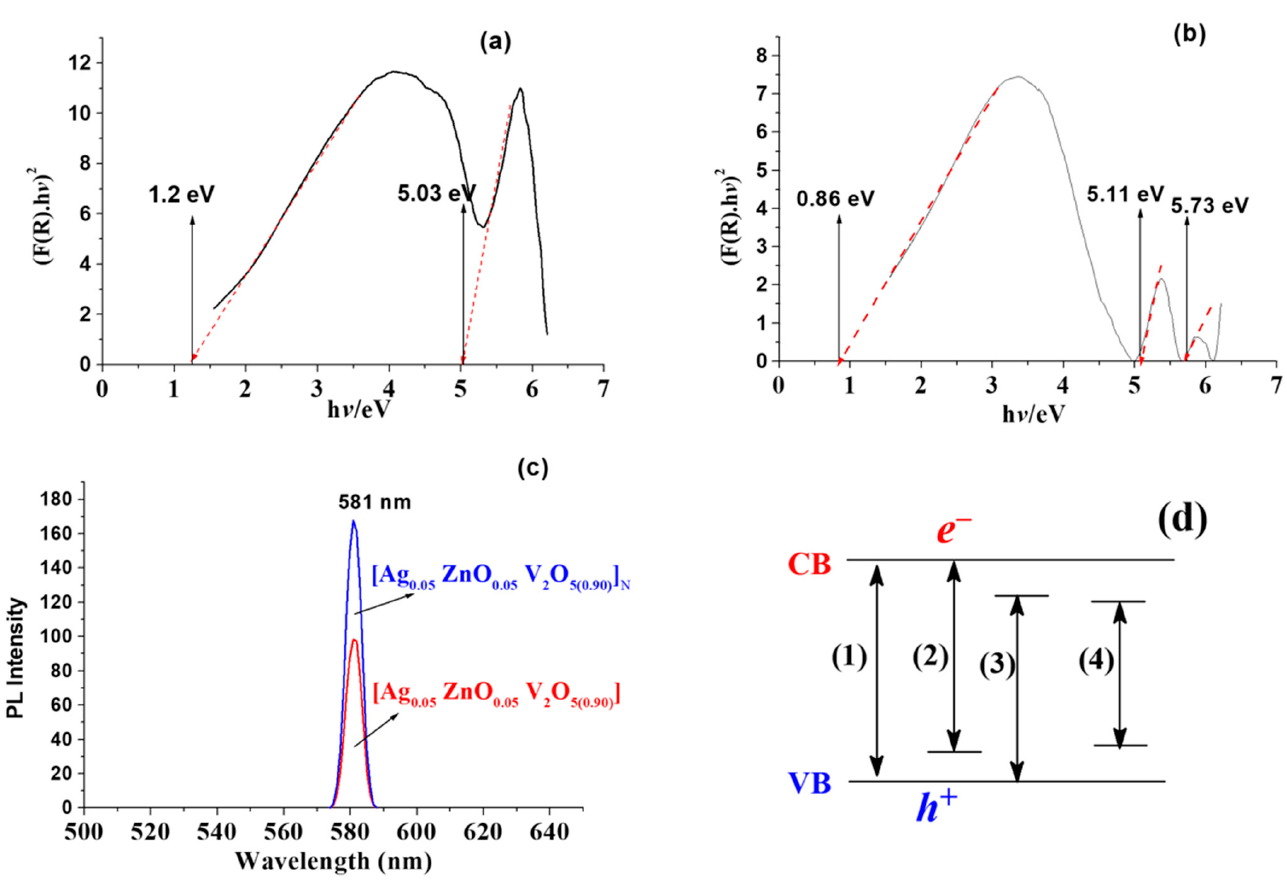
Figure 7. The bandgap energy calculated from Tauc plot of ( a ) [Ag 0.05 ZnO 0.05 V 2 O 5(0.90) ], ( b ) [Ag 0.05 ZnO 0.05 V 2 O 5(0.90) ] N ; ( c ) the PL spectra of the as-prepared catalysts, and ( d ) the band structure of (1) bare catalyst, (2) metal-doped, (3) nonmetal-doped, and (4) metal-nonmetal-doped catalyst.